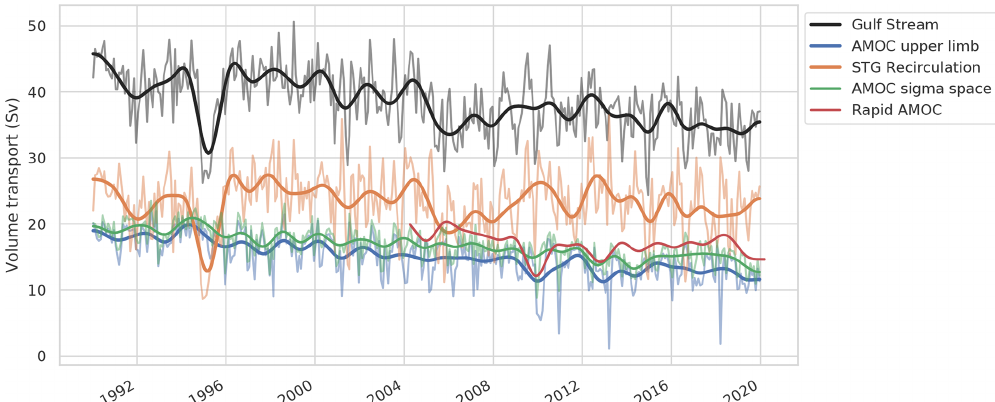
Figure 9. Northward transports and AMOC strength at 29 ◦ N in VIKING20X. Pale lines are monthly mean data; darker lines are low-pass filtered using a Butterworth filter and 18-month cutoff. The total transport in the Gulf Stream (black line) reduces throughout the experiment duration, while the volume recirculating in the subtropical gyre above 1000m (light orange line) shows a smaller trend or remains largely constant. This implies weakened AMOC and reduced northward flow in the AMOC upper limb (blue, AMOC in z -space). At 29 ◦ N, the AMOC in σ -space (green) is very similar to AMOC z and also reduces consistently. The dark orange line is AMOC in z -space from RAPID observations, low-pass filtered at 18 months, for comparison. The reducing AMOC strength (blue and green) closely reflects the reducing contribution of Gulf Stream origin transport at OSNAP E found from the particle